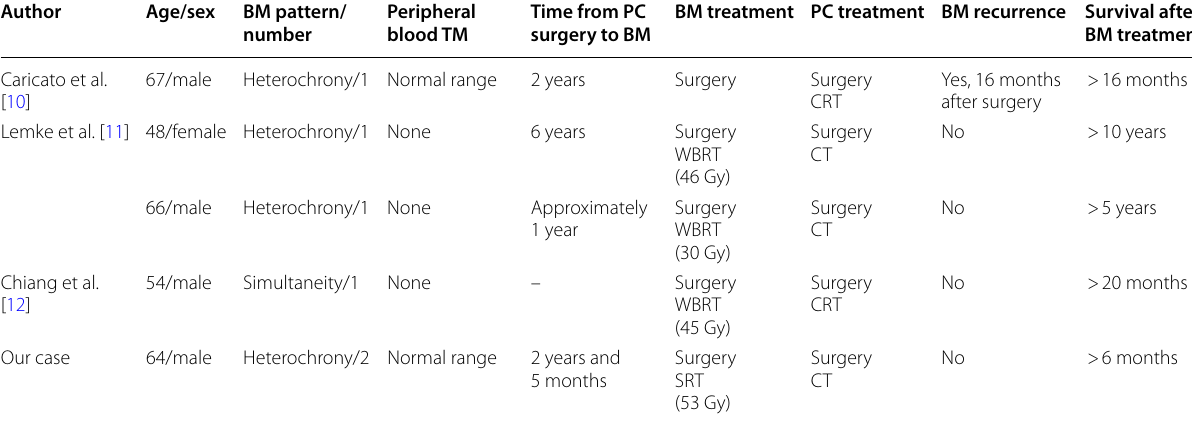
BM brain metastasis, TM tumor marker, RT radiation therapy, PC pancreatic cancer, CRT chemoradiation therapy, CT chemotherapy, WBRT whole-brain radiotherapy, SRT stereotactic